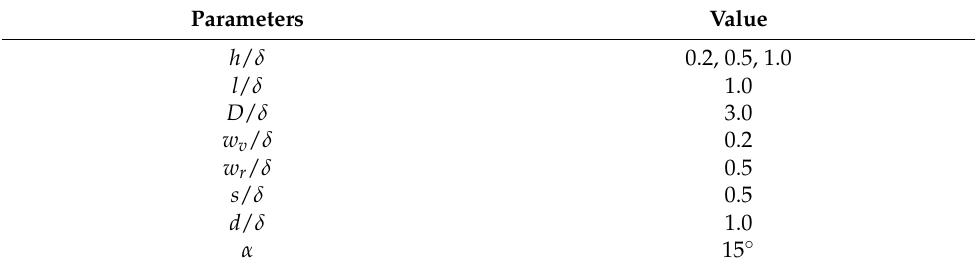
Table 1. Geometry of the VGs.